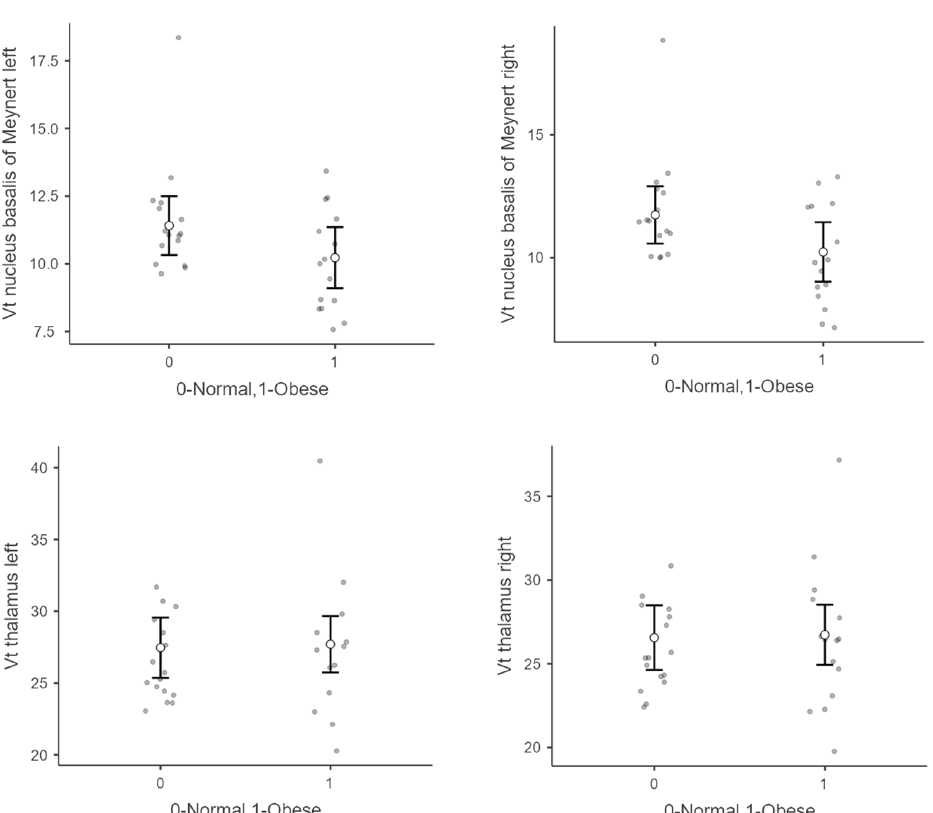
Figure 3. Total distribution volume (V T ) of ( − )-[ 18 F]flubatine in individuals with obesity and normal- weight controls in the right and left nucleus basalis of Meynert and the right and left thalamus shown as Jitter plots. The mean value is depicted with the white point and error bars representing the standard deviation. Individual data points are represented in gray.